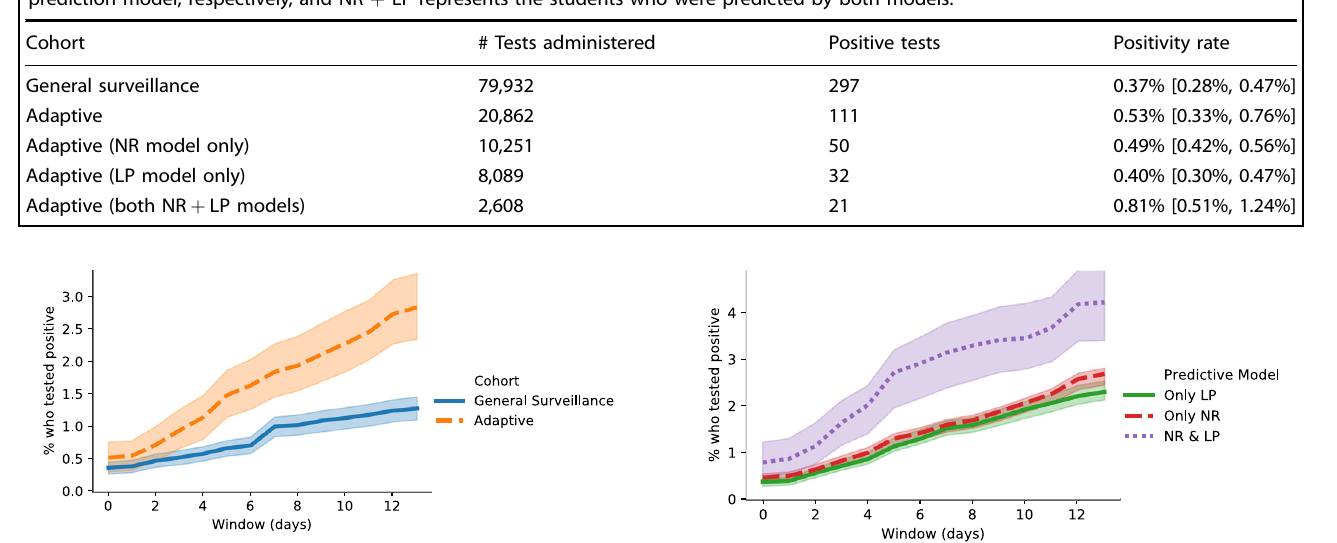
Fig. 1 The percentage of students who tested positive during the initial appointment or a follow-up test within 14 days. Day 0 is the day they were selected for the cohort. Shaded regions indicate 95% con fi dence intervals.